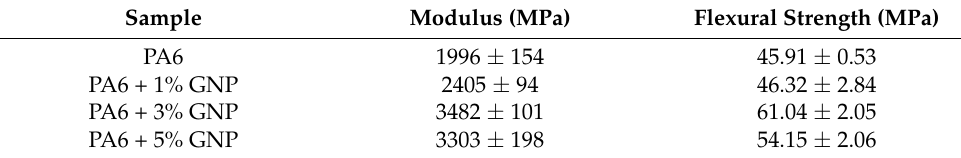
Figure 4. Representative stress–strain flexural curves of investigated samples (solid line: PA6, dashed line: PA6 + 1% GNP, dashed and dotted line: PA6 + 3% GNP, dotted line: PA6 + 5% GNP). Table 4. Flexural parameters.